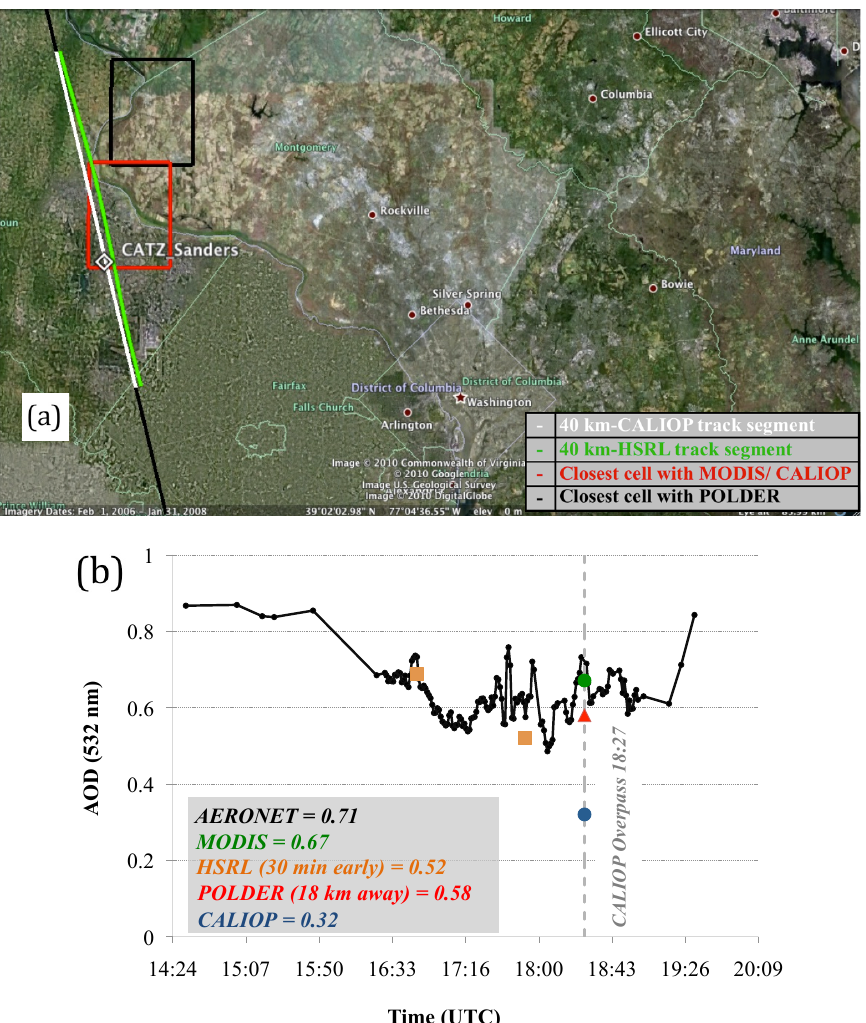
Fig. 2. 4 August 2007 – (a) Co-localization of CATZ-Sanders (white diamond), the closest 40km-CALIOP track segment (white line), the corresponding closest 40km-HSRL track segment (green line), the 12 × 12km closest CMAQ cell (red box) reporting available MODIS and CALIOP version 2 AOD data and the closest CMAQ cell reporting available POLDER AOD data (black box); (b) Temporal evolution of AERONET CATZ-Sanders direct sun AOD measurements (black) and the collocated HSRL AOD retrievals during the two overpasses (AOD 532 of Table 2, orange); At the time of the A-Train overpass (18:27UTC, dotted grey line) over CATZ-Sanders: in green, the MODIS AOD retrieval (red box of (a) ), in red, the POLDER AOD value (black box of (a) ) and in blue, the CALIOP version 2 AOD value (red box of (a) ). All AOD observations are either retrieved or computed at 532nm (use of the ˚Angstr¨om exponent between 440–675nm, 470–670nm and 865-670nm for AERONET, MODIS and